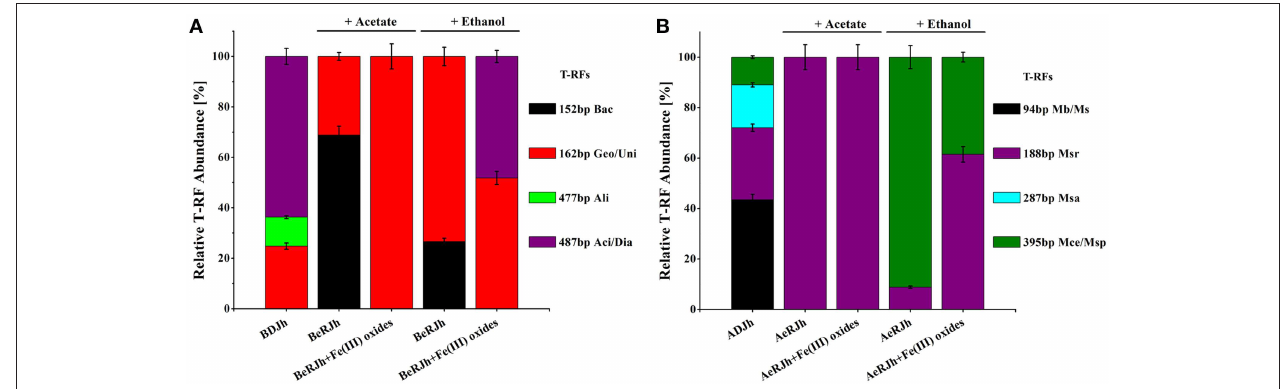
FIGURE 4 | Community characteristics of bacteria and archaea in the sediments before and after the enrichment incubations, as revealed by T-RFLP and clone libraries of 16S rRNA genes. (A) Relative abundance of different bacterial T-RFs from DNA and RNA extracted from in situ sediments and enrichment cultures (with or without Fe(III) oxides treatment). T-RF fingerprints were generated using Msp I restriction enzyme. Bac -Bacillus ; Geo -Geobater ; Uni- Unidentified ; Ali -Alishewanella ; Aci/Dia -Acidovorax/Diaphorobacter . (B) Relative abundance of different archaeal T-RFs from DNA and RNA extracted from in situ sediments and